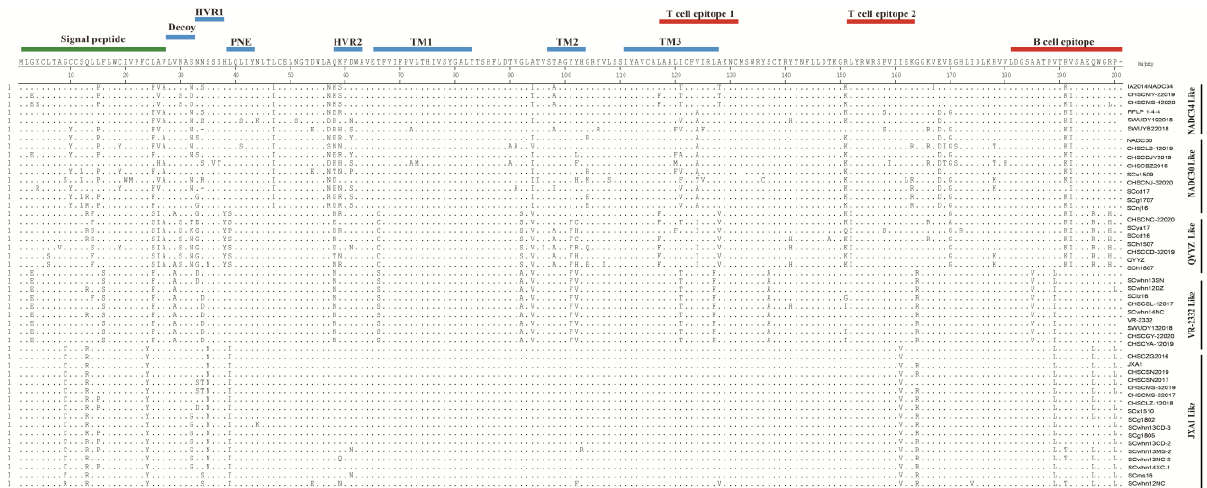
Figure 4. Amino acid sequence alignment of GP5 protein.